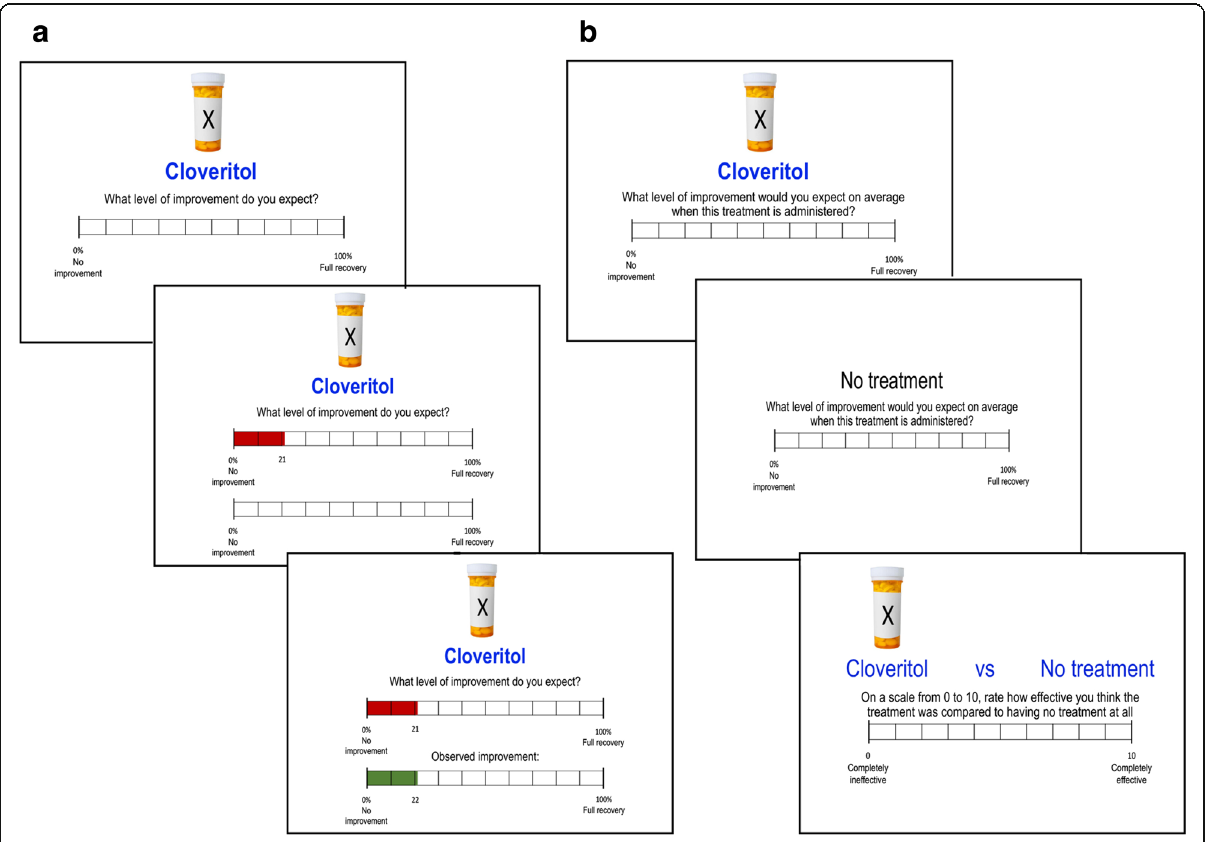
Fig. 2 Task schematics for a the sequence presented on a single training trial and b three test phase questions in Experiments 1 and 2. Causal ratings were made on a scale from 0 to 10 in Experiment 1, and − 100 to +100 in Experiment